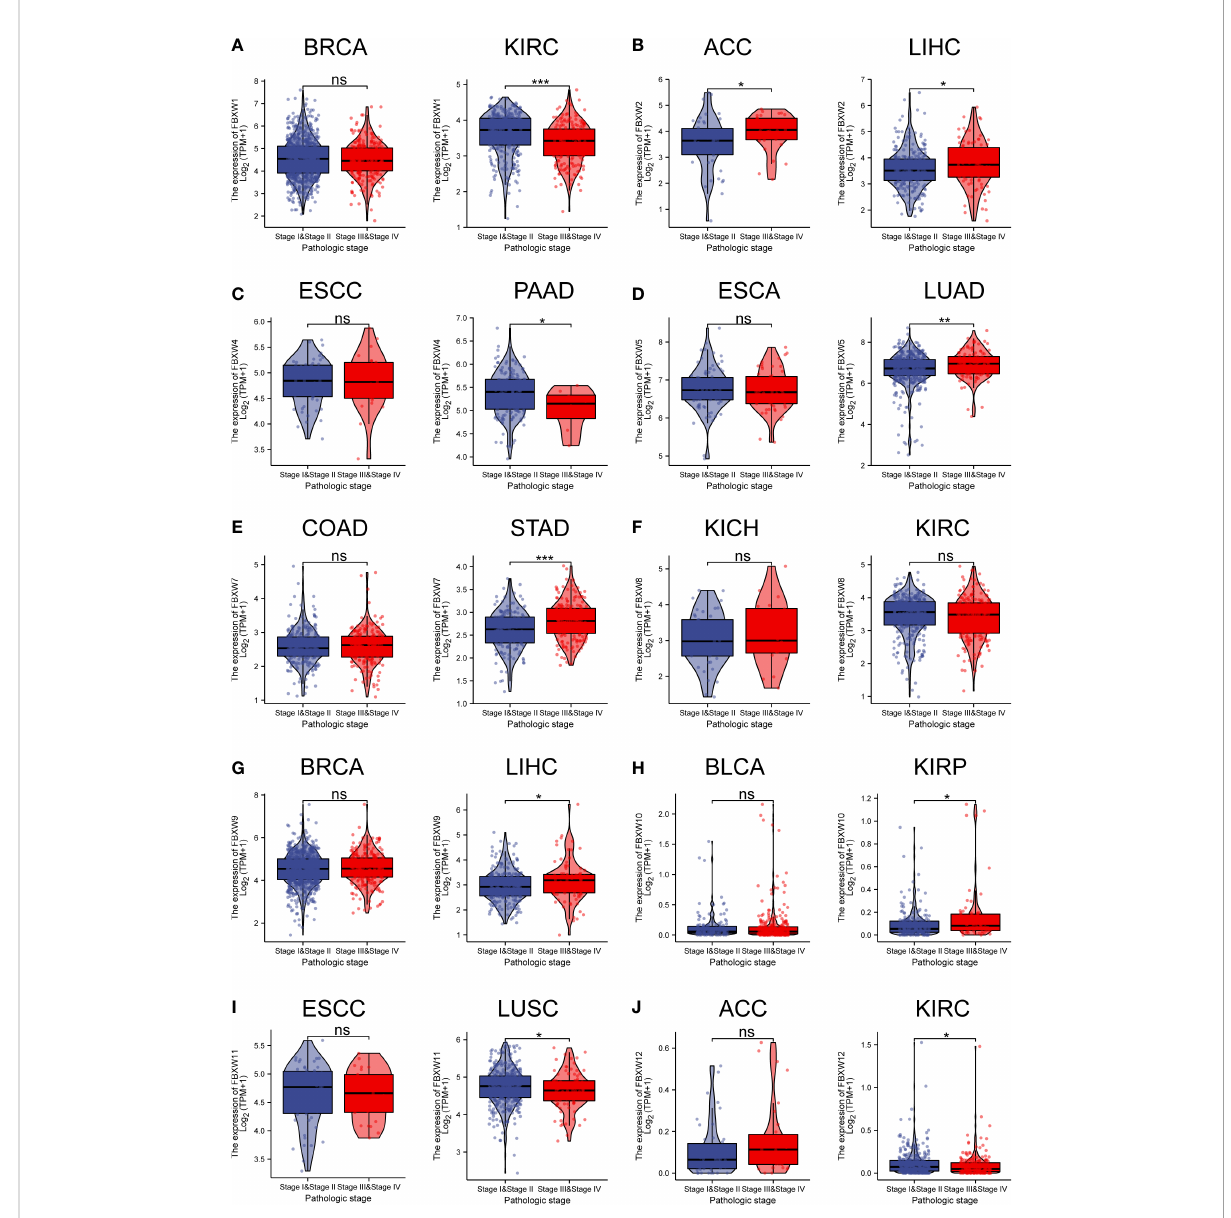
FIGURE 4 Association of FBXW family (A – J) gene expression with the clinical stages for different cancer types. ∗ P< 0.05, ∗∗ P< 0.01, and ∗∗∗ P< 0.001, ns, No statistical signi fi